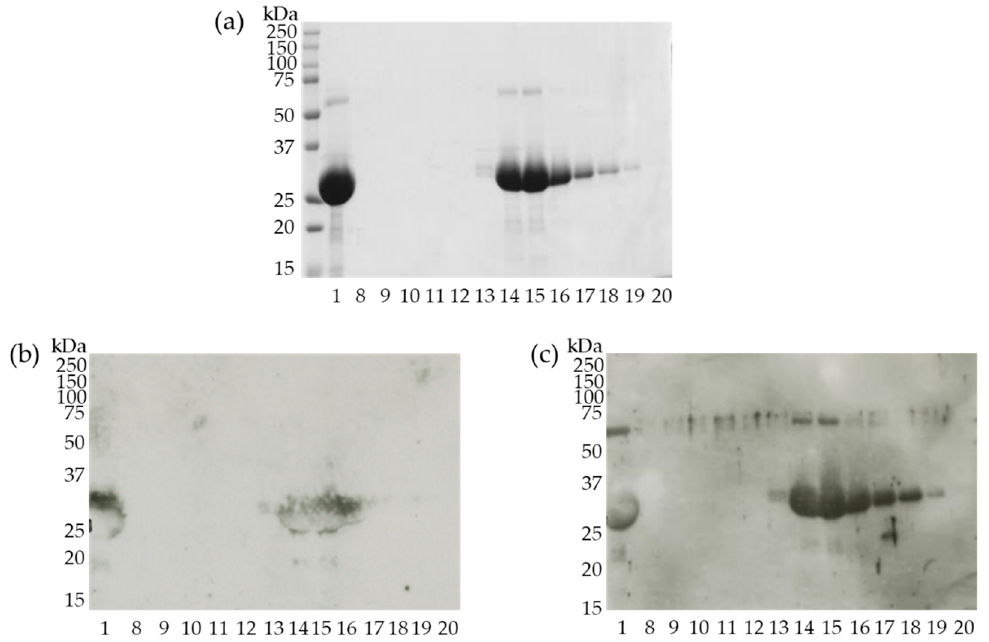
Figure 5. Separation of cherry proteins using gel-filtration HPLC ( a ) Coomassie brilliant blue staining of separated cherry proteins. ( b ) Immunoblotting using fractionated cherry proteins, mice sera, and HRP-labeled antimouse IgE antibody. ( c ) Immunoblotting using fractionated cherry proteins, mice sera, and HRP-labeled antimouse IgG1 antibody. 1, applied sam- ple; 8–20, corresponding eluted faction number.